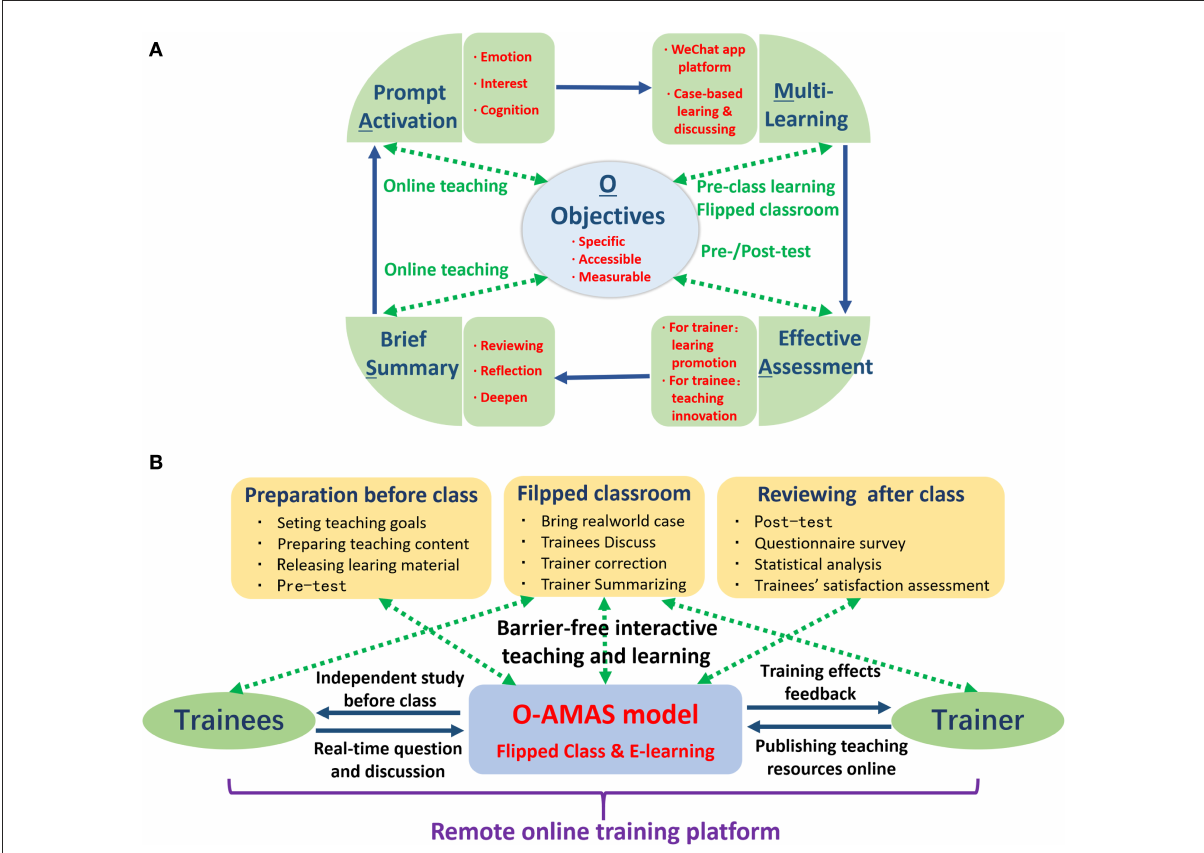
FIGURE1 The design and development of the continuing training program for community pharmacists. (A) Overall design based on the O-AMAS model and flipped classroom. (B) Flow diagram for the organization of the training program.